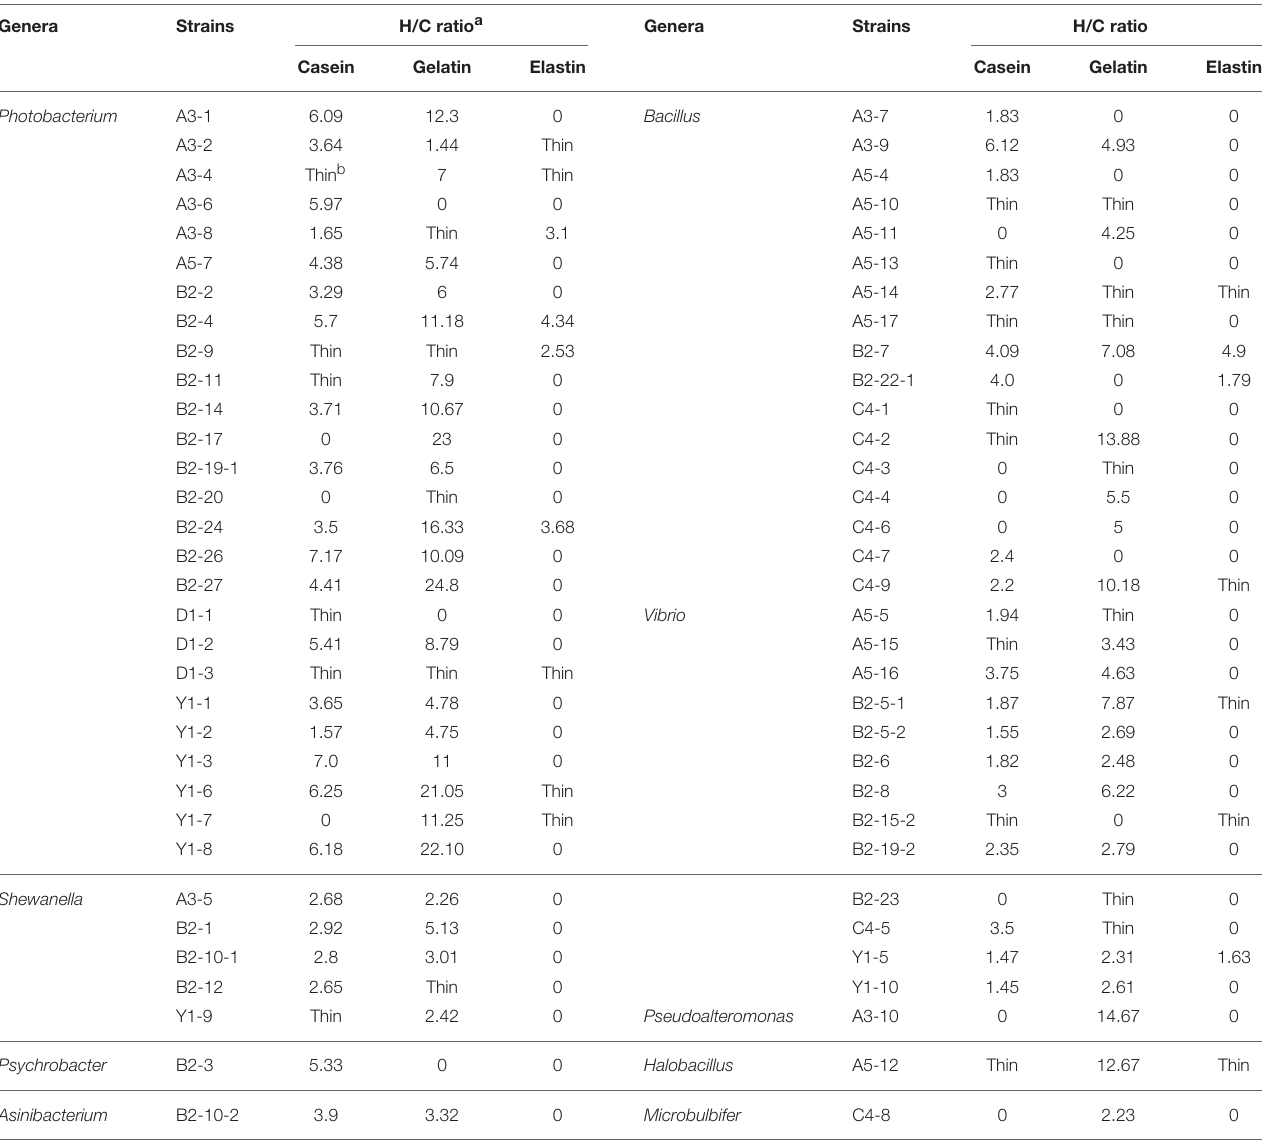
TABLE 3 | The H/C ratios of the strains on the plates containing casein, gelatin, or elastin. Genera Strains H/C ratio a Genera Strains H/C ratio Casein Gelatin Elastin Casein Gelatin Elastin